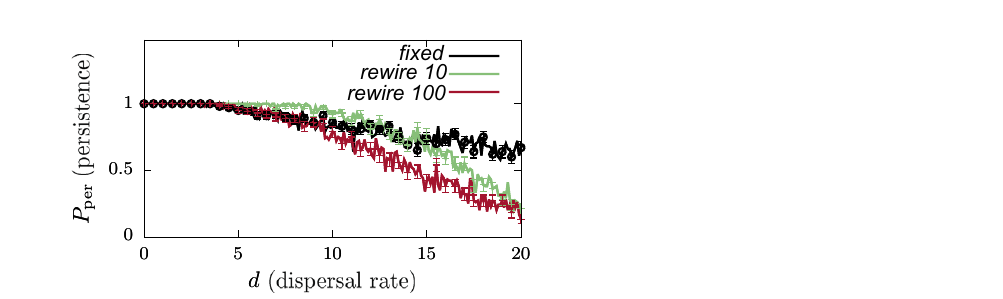
Figure 4. Persistence probabilities P per as a function of the dispersal rate d for ( a ) fixed, and ( b ) rewiring 100 network realizations were used for the simulations, for N (every 100 time units) NBMs. N ensemble = 20 (red) and N 40 (black) network sizes. Standard error values SE ( P per ) for these calculations are (blue), N = = highlighted by error bars every four data points. Related biomass calculations can be seen in Online Appendix Fig. A.2.